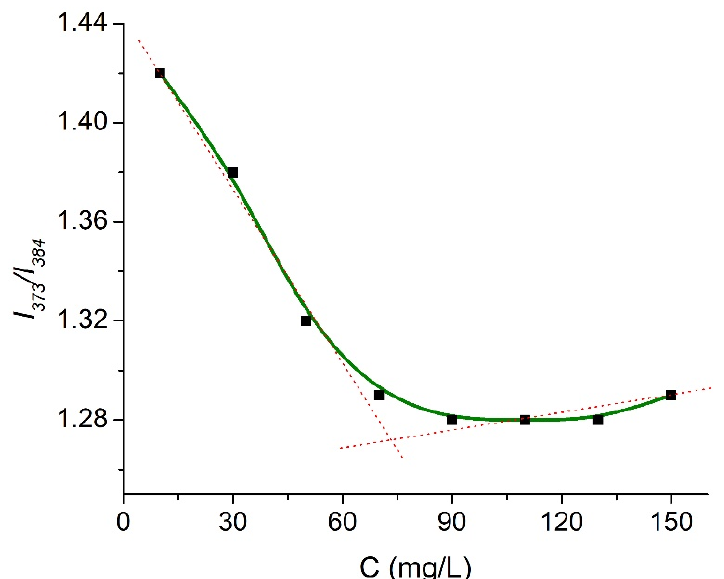
Figure 5. A graph of fluorescence intensity ratio versus polymer solution concentrations to determine the critical micelles concentration (CMC).